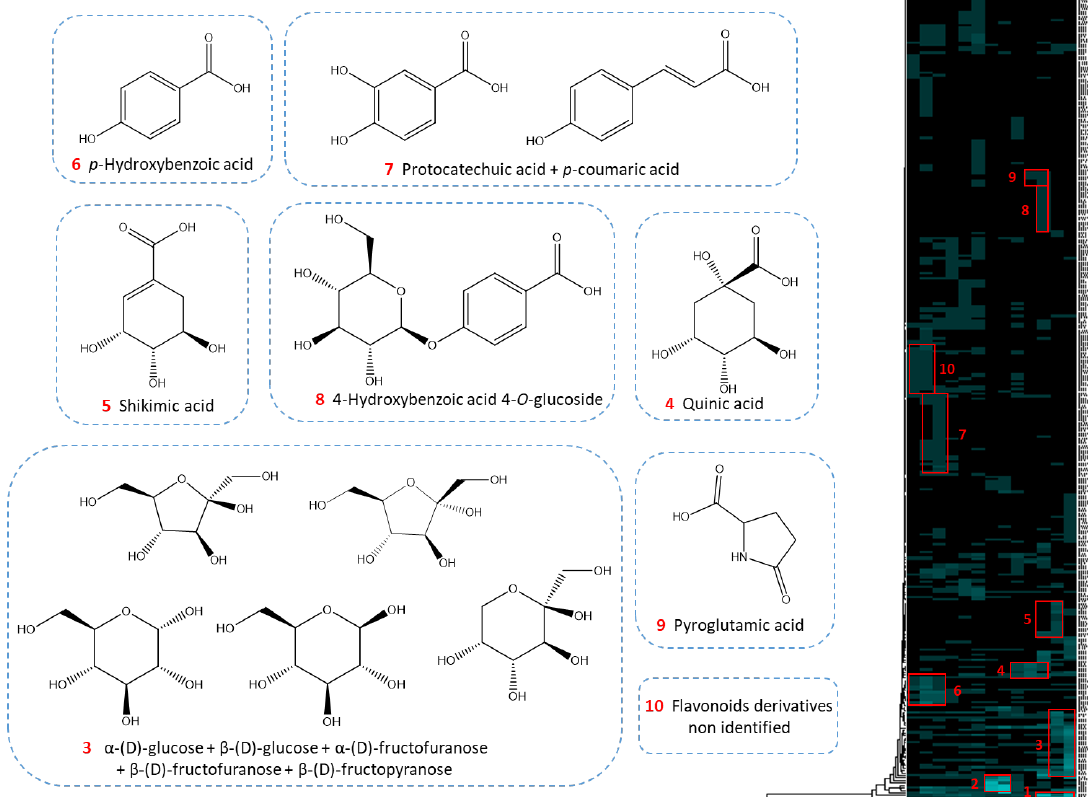
Figure 8. 13 C-NMR chemical shift clusters obtained by applying HCA on CPC fractions of glycerinated extract of C. atlantica .